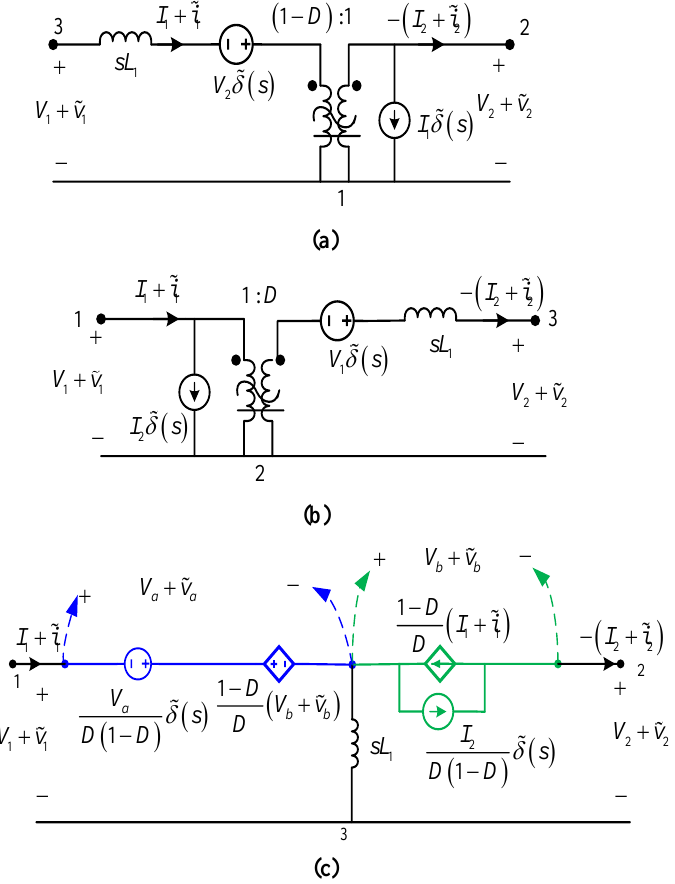
Figure 5. Ideal averaged small-signal/steady-state equivalent circuit for Type 1 BBB variants. ( a ) Switch to rail, ( b ) diode to rail, and ( c ) inductor to rail.